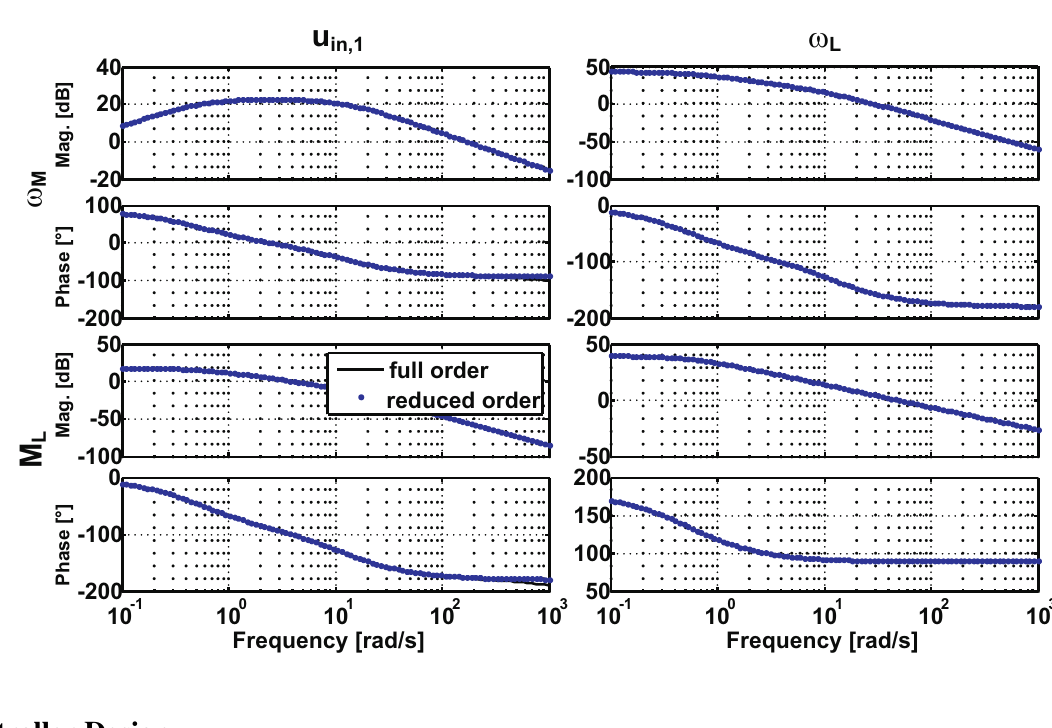
Figure 3. Bode diagram of the full order (dashed) and the reduced order system.